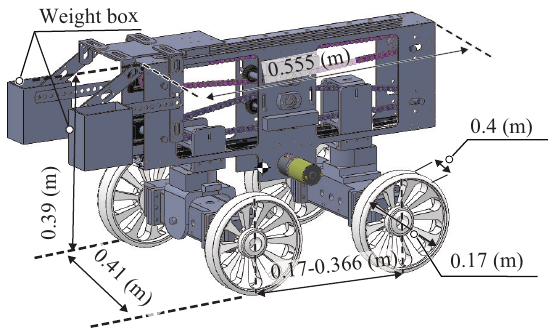
Figure 1. Schematic view of the testbed rover with the function of push–pull locomotion